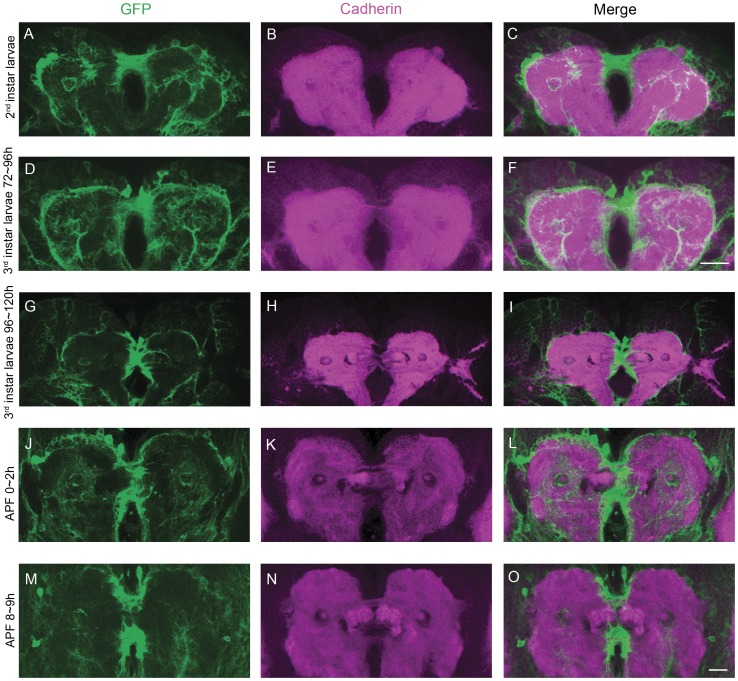
The expression pattern of C767-Gal4 and DN-cadherin signal during FB formation in cbd KS171 mutants.(A–C) 2nd instar larval brain. (D–F) early 3rd instar larval brain. Scale bar in (F) equals 25 µm and applies to (A–F). (G–I) late 3rd instar larval brain. (J–L) pupal brain 0–2 h APF. (M–O) pupal brain 8–9 h APF. Scale bar in (O) equals 25 µm and applies to (G–O).